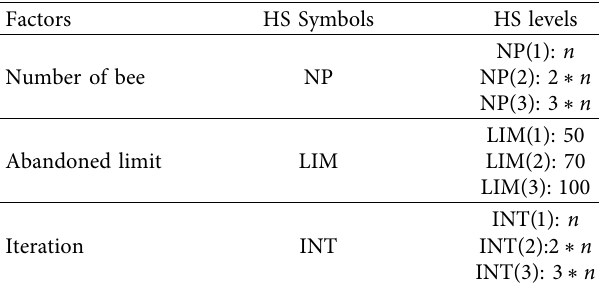
Table 5: Factors and candidate levels in artificial bee colony (ABC) optimization